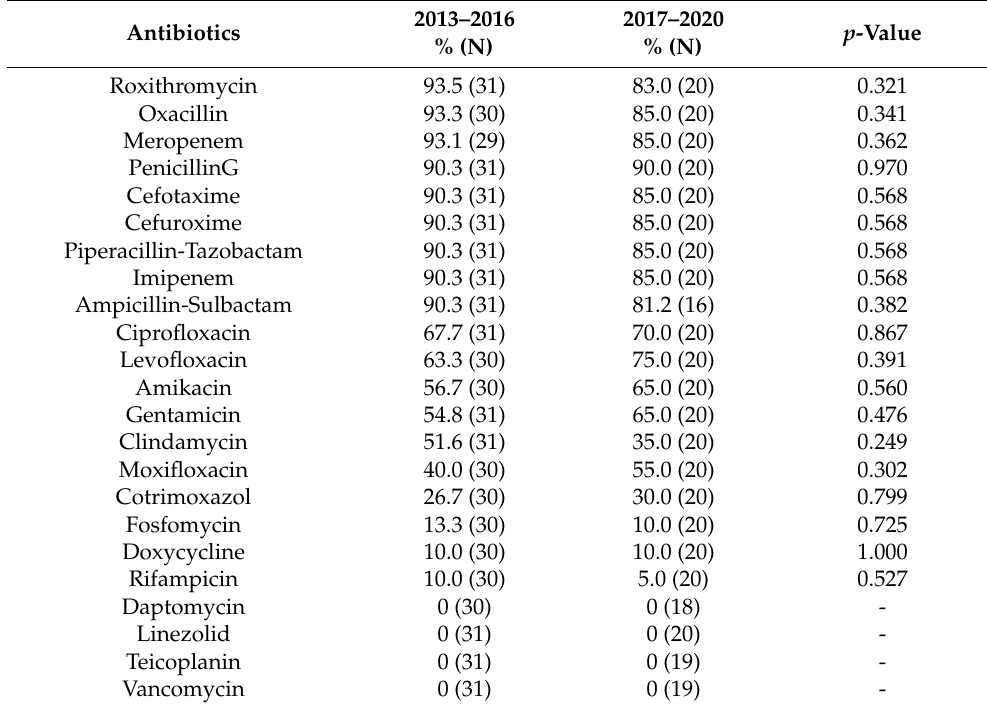
Table 3. Trends in antibiotic resistance of Staphylococcus epidermidis isolates from neonatal sepsis patients,